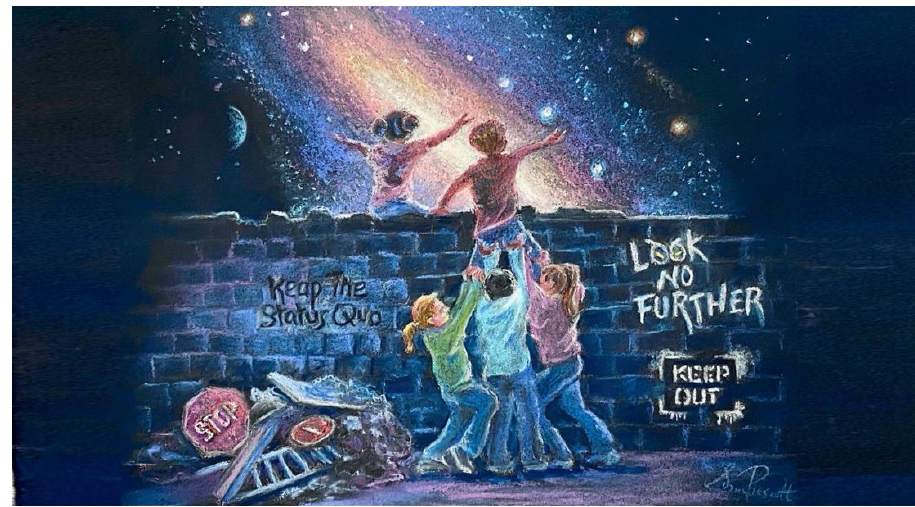
Figure 6. “Looking over the parapet”: Aspirational goals for new horizons of possibility. (Art created by author S.L.P.).